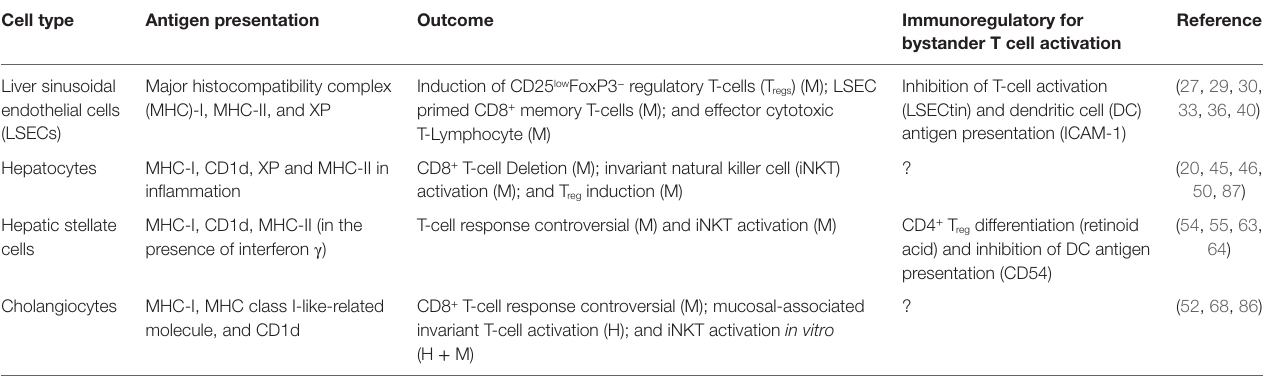
TABLe 1 | Non-professional antigen-presenting cells and their immunoregulatory effect in the liver XP: cross-presentation; ?: not investigated in the liver; investigated in human (H) or in mouse (M) samples. Cell